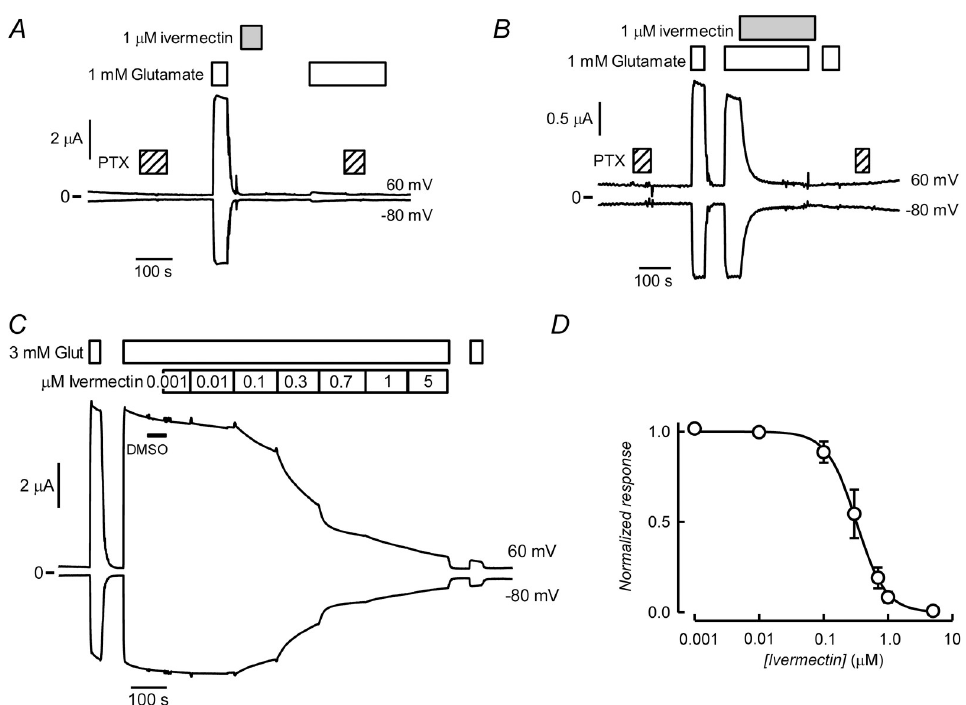
Fig 4. Ivermectin antagonises the effect of glutamate on CrGluCl-B. A and B. Effect of ivermectin on the response of CrGluCl-B to glutamate. Current traces were obtained at the indicated membrane potentials during bath application of 1 mM glutamate as affected by ivermectin application at 1 μ M during the times shown in the boxes. The current evoked by glutamate was 4.67 ± 1.17 μ A before and 1.70 ± 1.69 after ivermectin treatment (means ± SD, n = 7). PTX shows addition of 100 μ M PTX. Black bar labelled DMSO indicates addition of 0.05% dimethyl sulfoxide, the highest concentration reached for the ivermectin solvent. C. Shows the effect of increasing ivermectin concentrations on CrGluCl-B current elicited by 3 mM glutamate addition. In D the extent of antagonism is illustrated in the ivermectin inhibitory concentration-response curve. The responses were normalised to the maximal effect evoked by glutamate. The line is a Hill equations fitted to the data sets which are means ± SD (n =